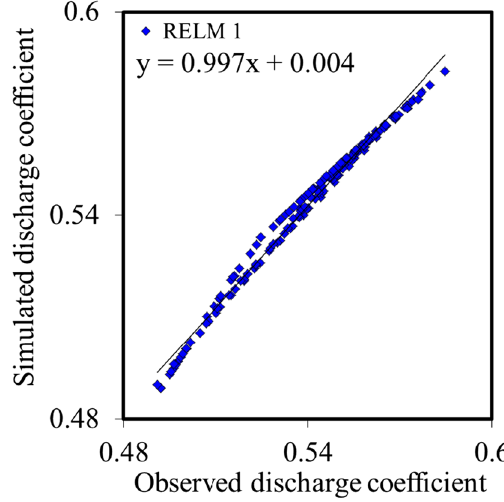
Fig. 12 Scatter plot for